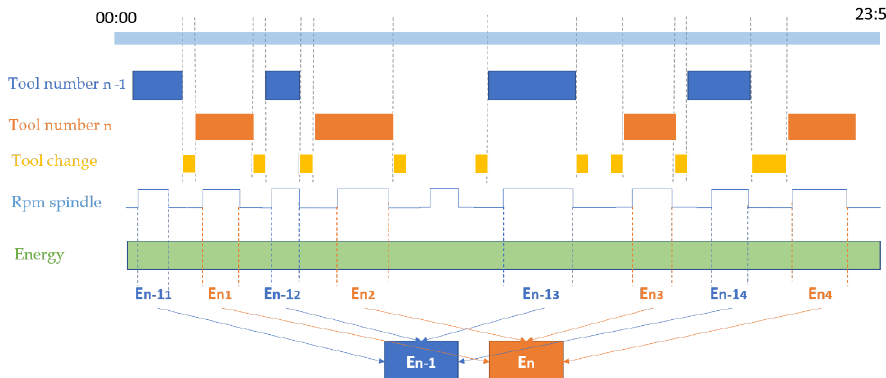
Figure 2. Flow chart of the calculations.